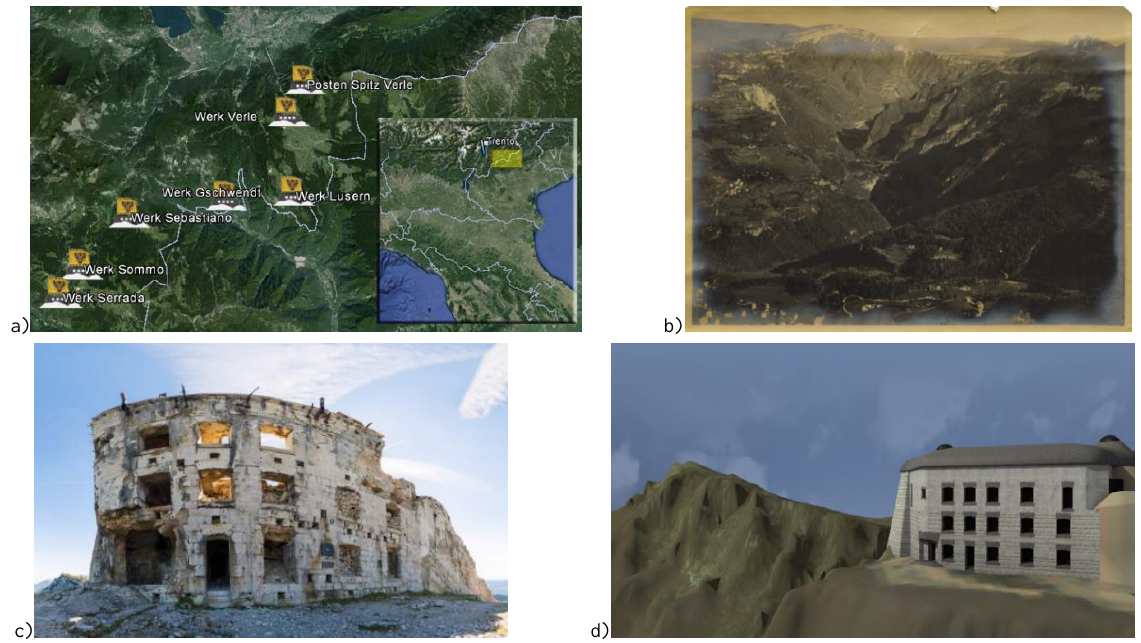
Figure 1. (a) Positions of the Austro-Hungarian forts along the old national border (before 1918) between Italy and the Austro–Hungarian empire - nowadays a regional border between Trentino – Alto Adige and Veneto (b) An historical picture showing the plateaus and highlands ‘Altipiani Cimbri’. (c) Vezzena fort as it appears today and (d) its virtual